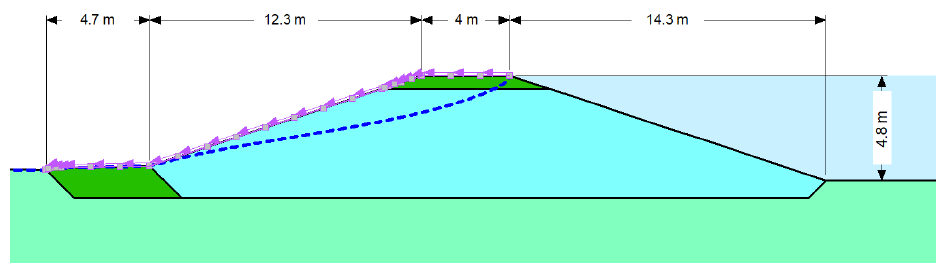
Figure 6. Numerical model for analyses of case study levee.